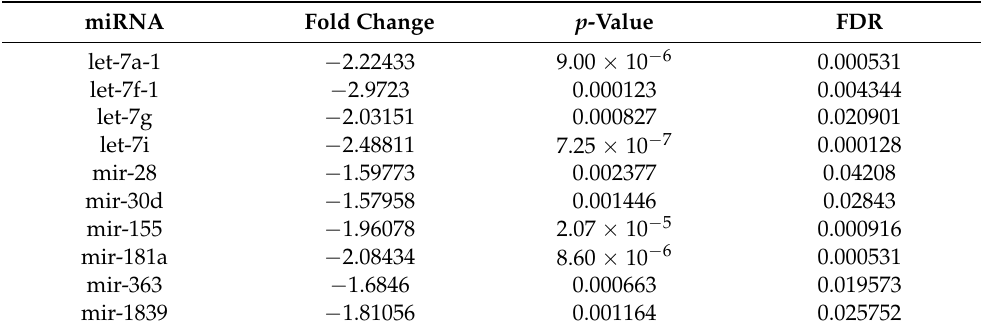
Figure 2. Volcano plot representing differentially expressed miRNAs at the screening study in peripheral blood of MetS and non-MetS obese subjects. Fold change represents the differential expression of miRs between MetS ( n = 6) and non-MetS ( n = 6) groups. Comparative analysis was performed by the Baggerley test corrected by false discovery rate (FDR) for multiple tests using the CLC Genomic Workbench software (Qiagen, Hilden, Germany). The red line indicates FDR = 0.05 and the dots above this line have FDR < 0.05. The dotted blue line indicates no change in expression values. Red dots represent miRNAs downregulated in MetS obese group. Table 2. miRNAs differentially expressed in peripheral blood of MetS and non-MetS obese subjects (Screening